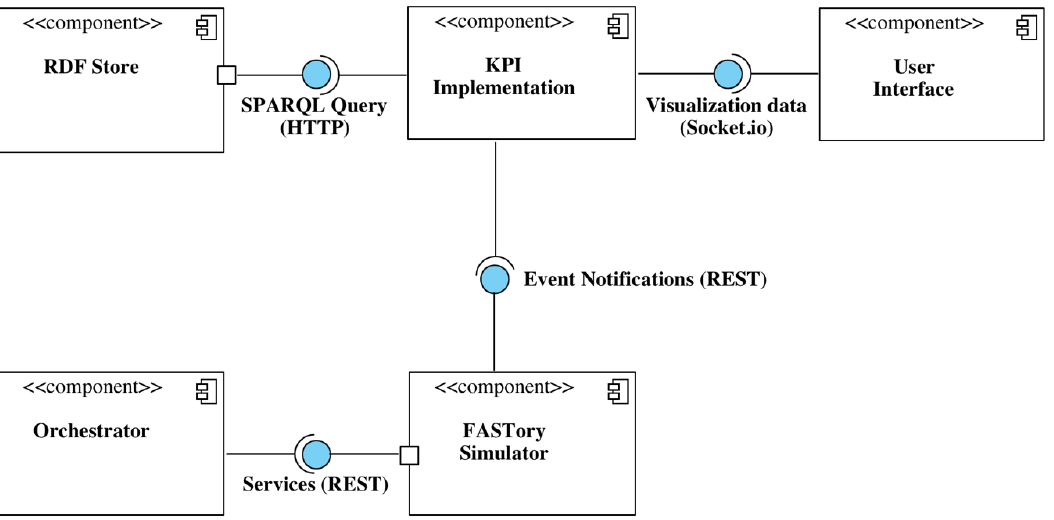
Figure 6. Interaction of components, modified from [52].